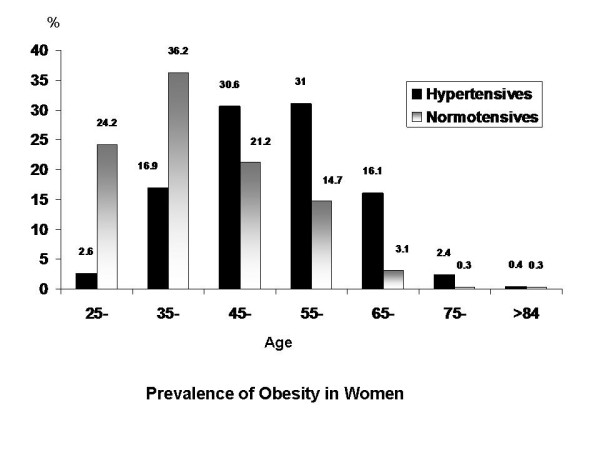
Prevalence of Abdominal Obesity(%) in Different Age Decades in Normotensive and Hypertensive Women.